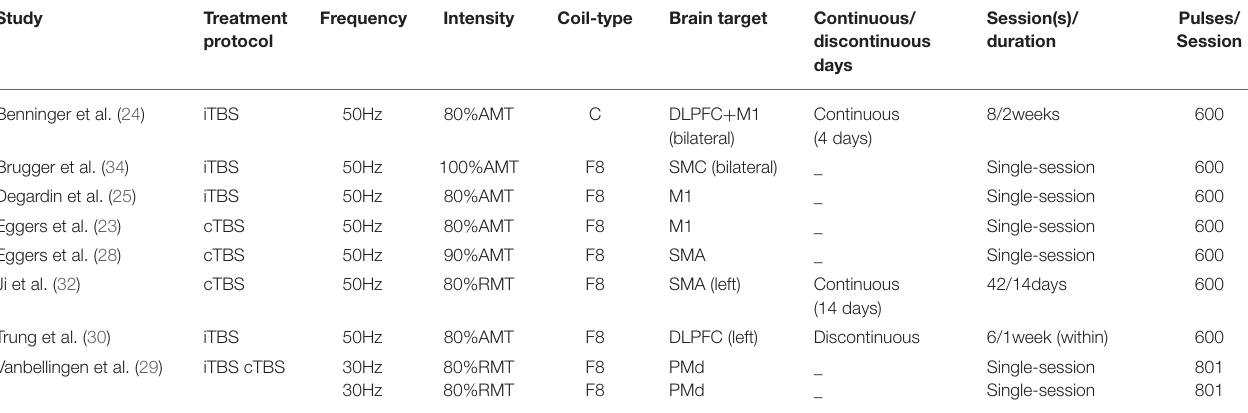
TABLE 2 | Study characteristics of TBS protocols included in the meta-analysis.